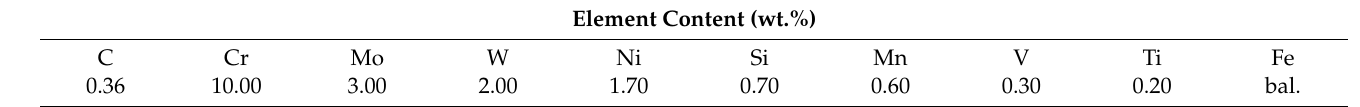
Table 1. Nominal chemical composition of the steel X36CrMoWVTi10-3-2 according to standardiza- tion. Element Content